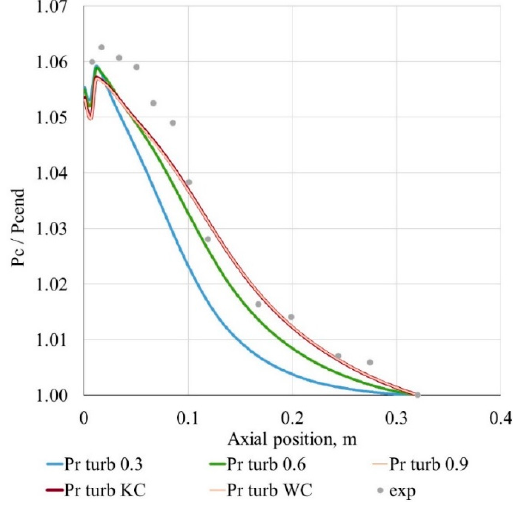
Figure 18. Axial normalized pressure.